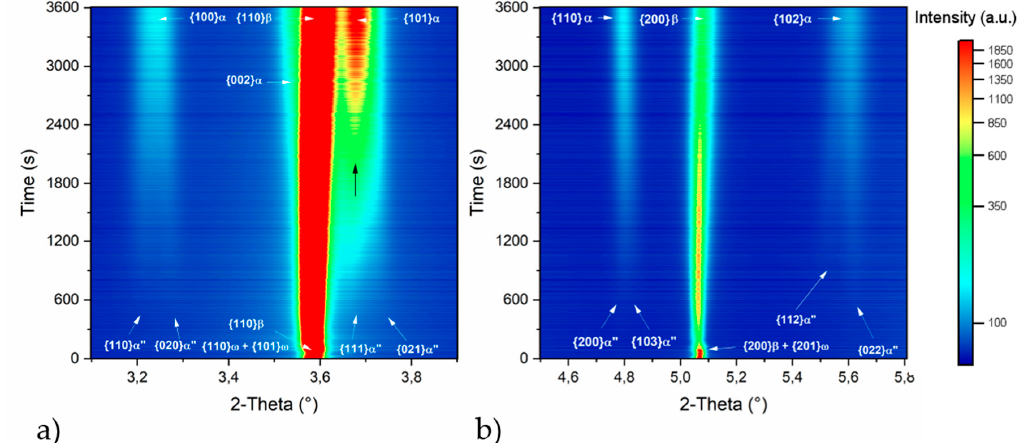
Figure 5. Color-coded plots showing the evolution of di ff raction patterns as function of time during Figure 5. Color ‐ coded plots showing the evolution of diffraction patterns as function of time during ageing for 2 θ intervals between ( a ) 3.1 and 3.9° and ( b ) 4.5 and 5.8°. The evident appearance of {101} α ageing for 2 θ intervals between ( a ) 3.1 and 3.9 ◦ and ( b ) 4.5 and 5.8 ◦ . The evident appearance of {101} α reflection is indicated by the isolated black arrow. reflection is indicated by the isolated black